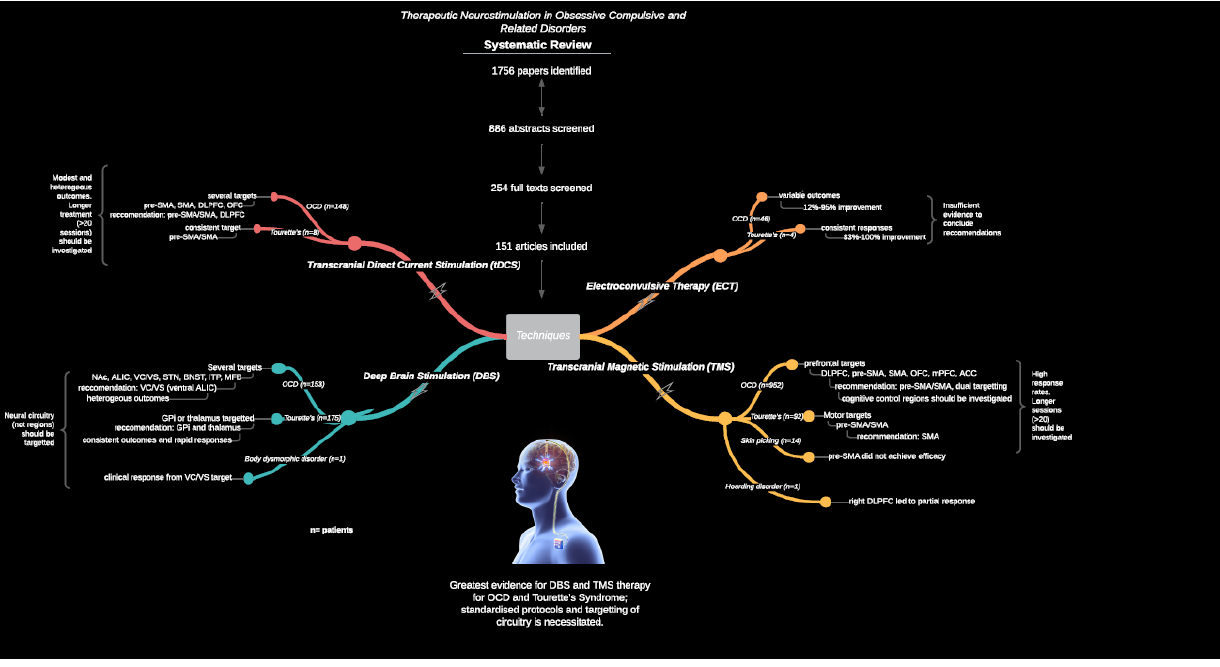
Figure 1. Graphical abstract.